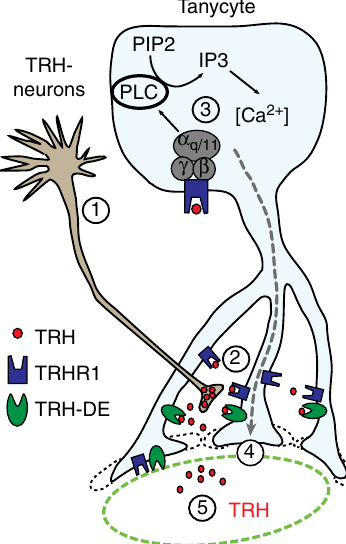
Fig. 8 Schematic illustration of the tanycyte effects on TRH release in the ME. Activation of hypophysiotropic TRH neurons in the PVN (1) leads to TRH release in the ME (2). TRH stimulates the TRHR1-dependent G α q/11 pathway, which results in activation of the phospholipase C and increase in [Ca 2+ ] i (3). Activation of the tanycytic G α q/11 pathway enlarges tanycytic endfeet, which may retain TRH in the ME (4) and increases the time for degradation of TRH by the upregulated TRH-DE. Overall, activation of tanycytic G α q/11 signaling results in a downregulation of the TRH release into the pituitary vessels